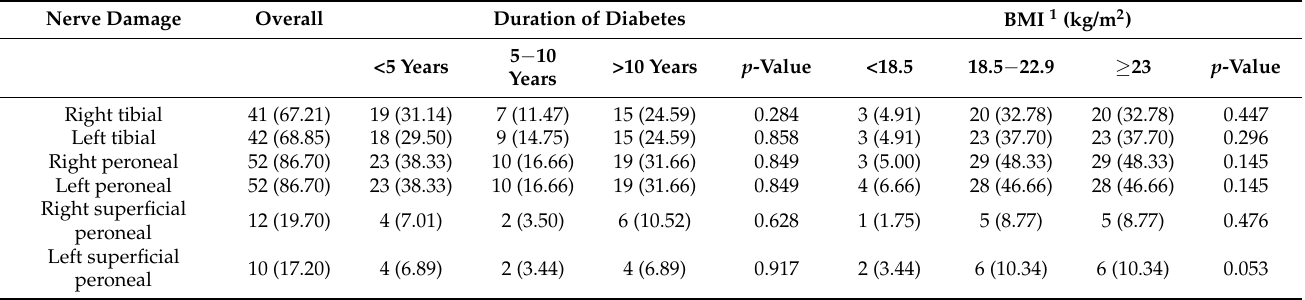
Table 6. Relationship between peripheral neuropathy and diabetes duration/group of BMI.